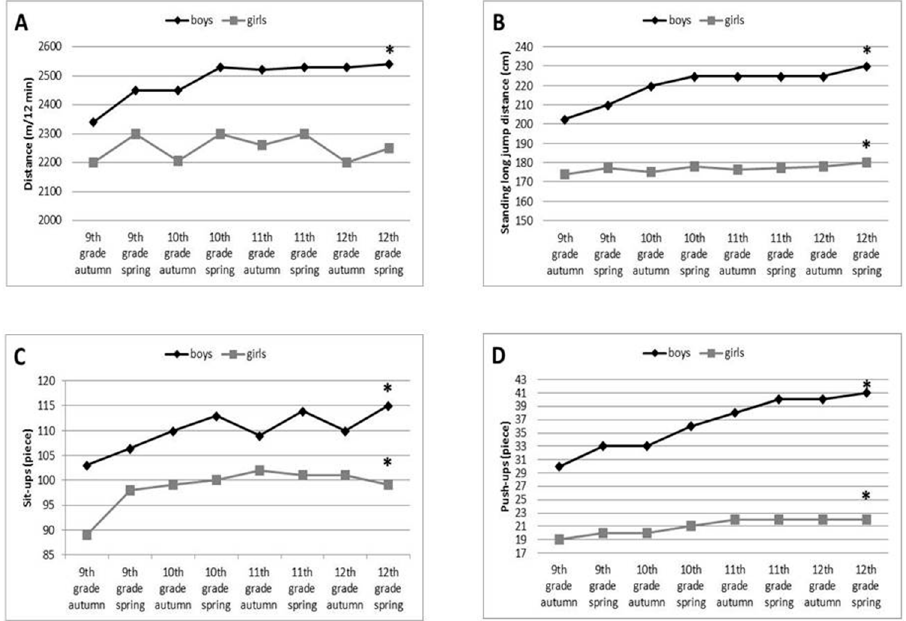
Figure 1. Changes in muscle strength and aerobic fitness between 9th and 12th grade in both genders. Significant improvement was detected in boys’ aerobic capacity according to 9th grade autumn and 12th grade spring data (data are shown as median, * = p < 0.05). However, only a seasonal variation was revealed in girls’ aerobic capacity during the 4 years ( A ). Significant improvement was detected in leg dynamic muscle strength (measured with long jump distance) ( B ), in the strength and endurance of abdominal muscles (measured by sit-up tests) ( C ), shoulder and arm muscles (measured by push-up tests) ( D ) in both genders during the 4-year observational period (data are shown as median, * = p < 0.05).